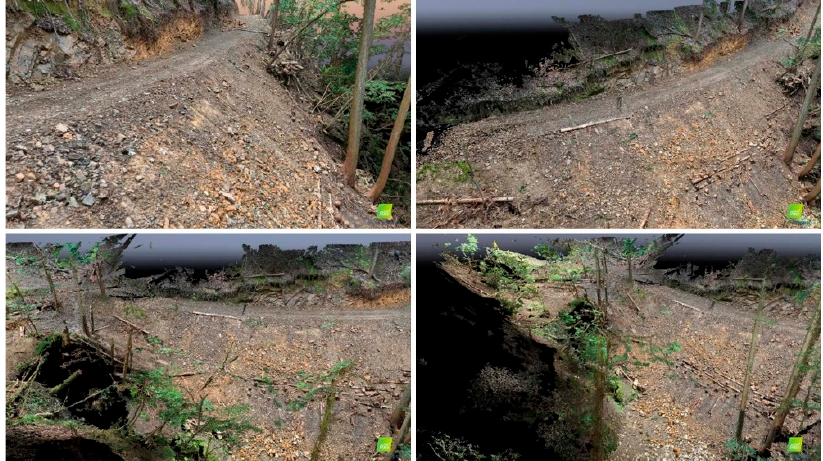
Figure 3. A 3D model generated by SfM analysis after the repair work completed.